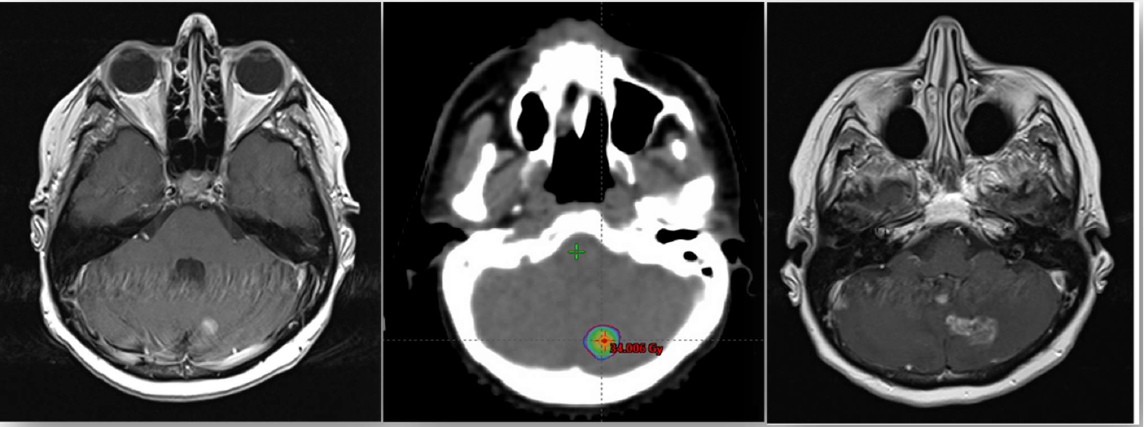
Figure 1. Brain MRI showing cerebral radionecrosis: (Left): T1-sequence MRI showing left cerebellar metastasis; (Middle) fSRT treatment planning; (Right) 12 months T1-sequence MRI: radionecrosis appearance. No other toxicity was experienced during treatment. No patient suspended PT.